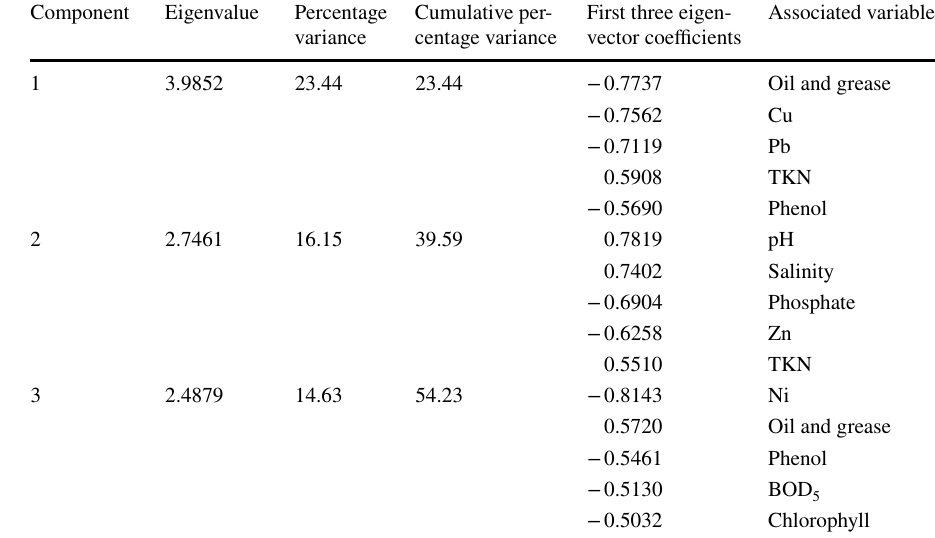
of physical and chemical parameters of Korangi Creek